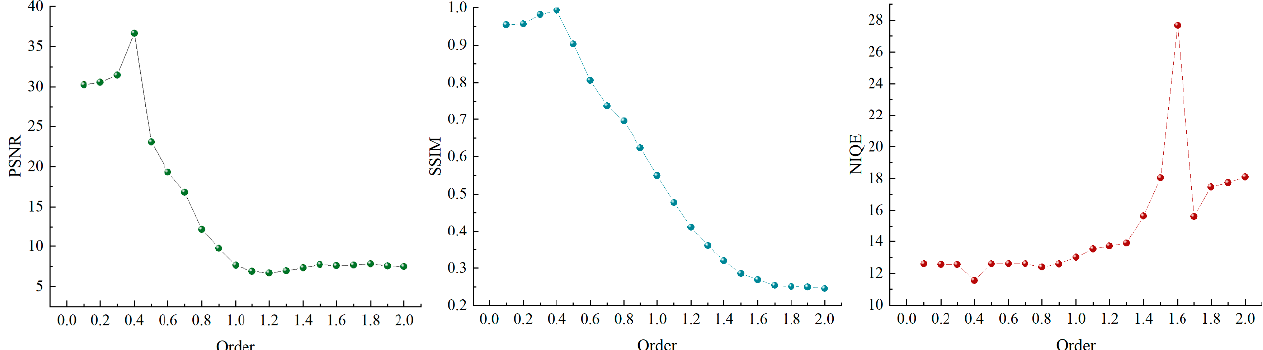
Figure 5. Three indicators used to evaluate the RGB image quality for 21 derivative orders (0 to 2, with an increment of 0.1 per step).